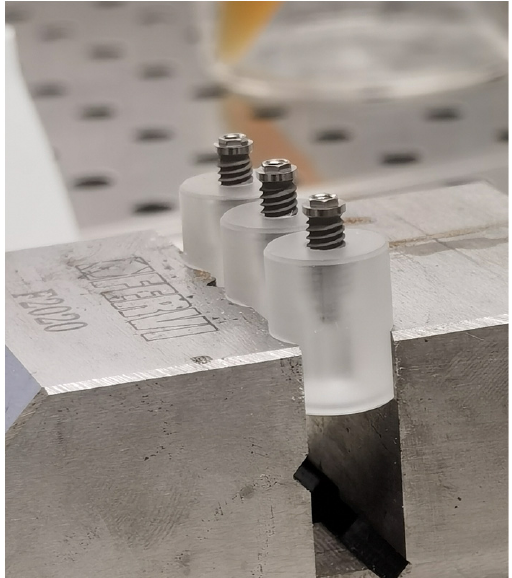
Figure 3. Insertion and fixation of the implant in a vinyl support.